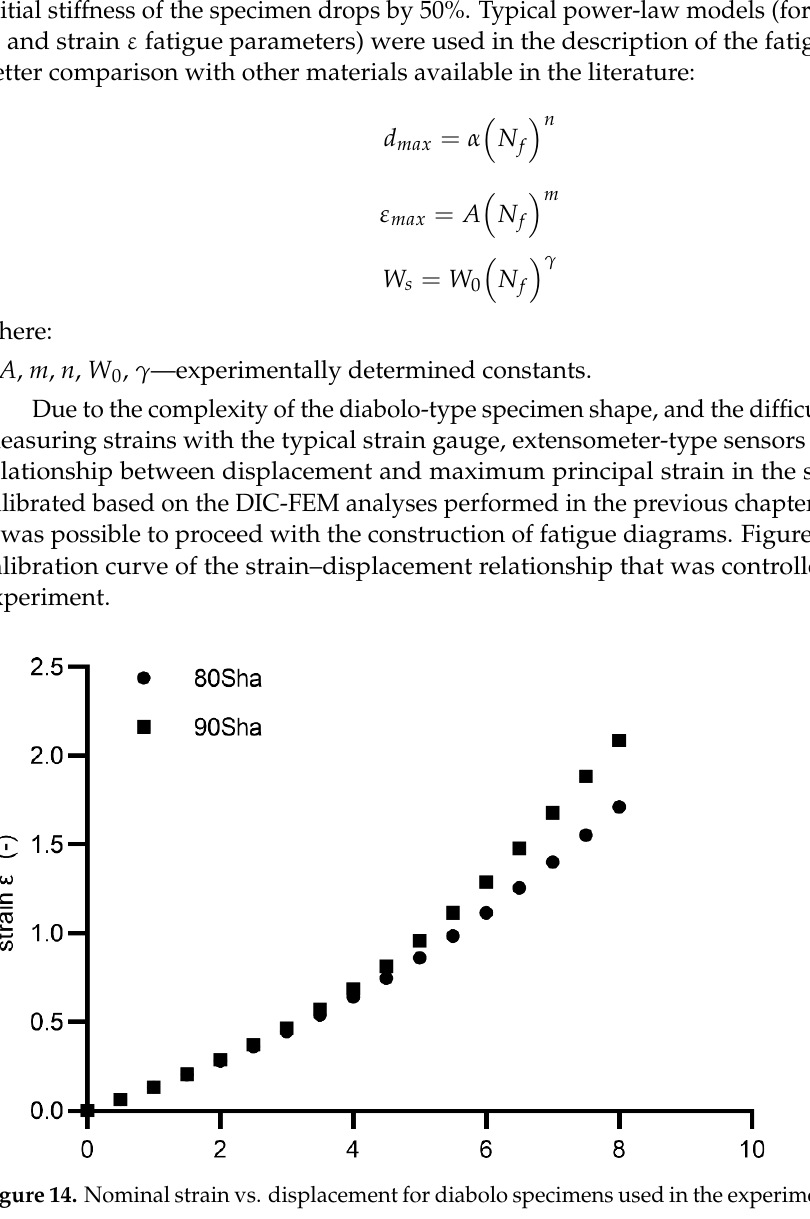
Figure 15. Energy vs. displacement for diabolo specimens used in the experimental campaign.